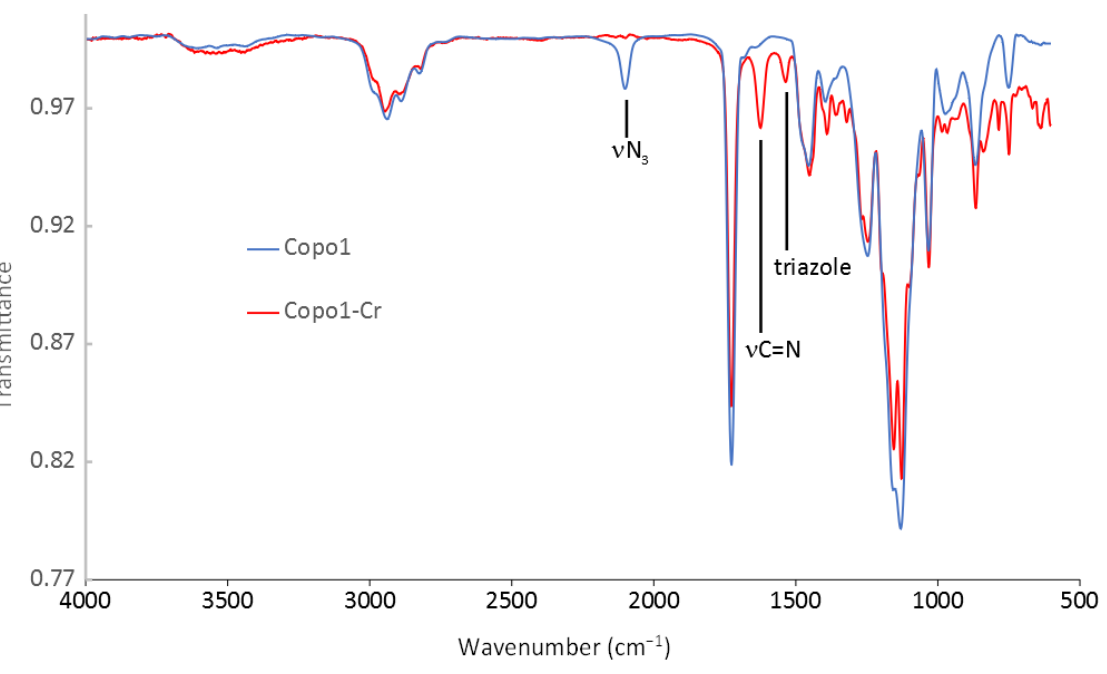
Figure 7. ATR-IR spectra of Copo1 (in blue) and Copo1-Cr (in